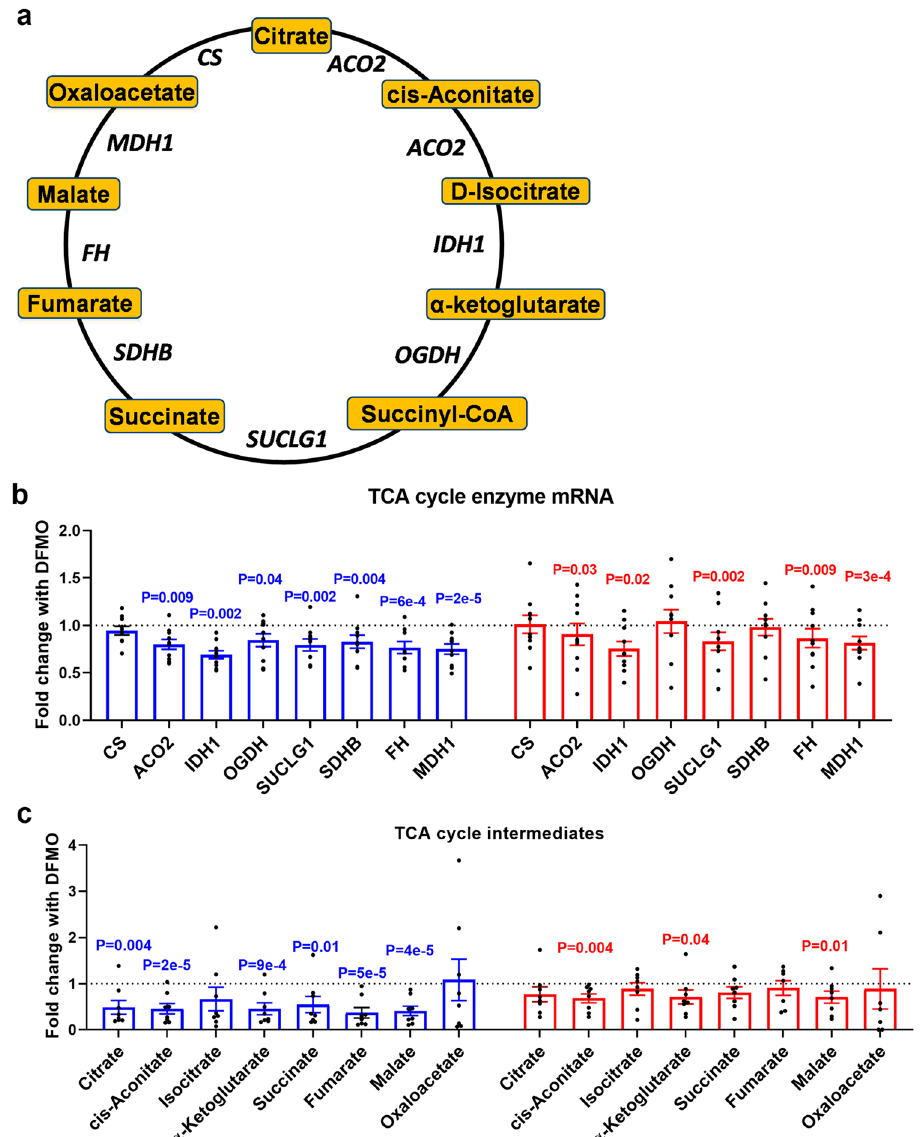
Fig. 3 Polyamine metabolism is linked to TCA cycle metabolism. a Illustration of the TCA cycle indicating the metabolites and enzymes measured. b TCA cycle enzyme mRNA measured by Q-PCR and ( c ) TCA cycle metabolites measured by LC-MS following DFMO-mediated polyamine depletion in PHTs. Bar graphs show mean ± SEM, N = 8 – 10 male PHTs and N = 8 – 10 female